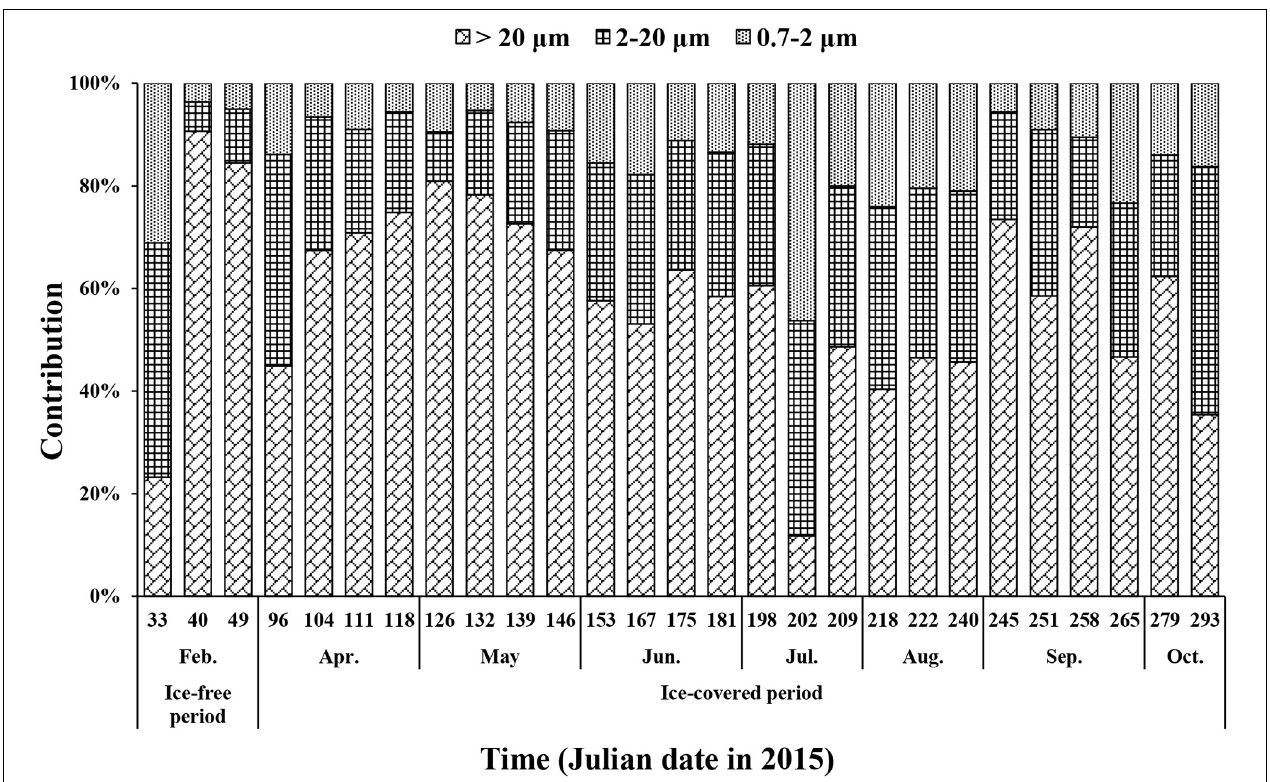
FIGURE 6 | The contributions of size-fractionated Chl- a concentration to the total Chl- a concentration of phytoplankton at JBS during the entire study period,